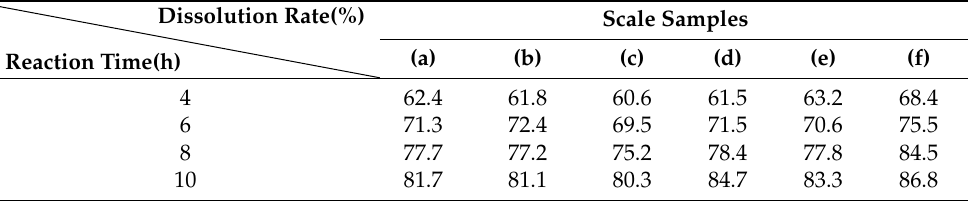
Table 2. The effect of reaction duration on the descaling performance of AST-01.